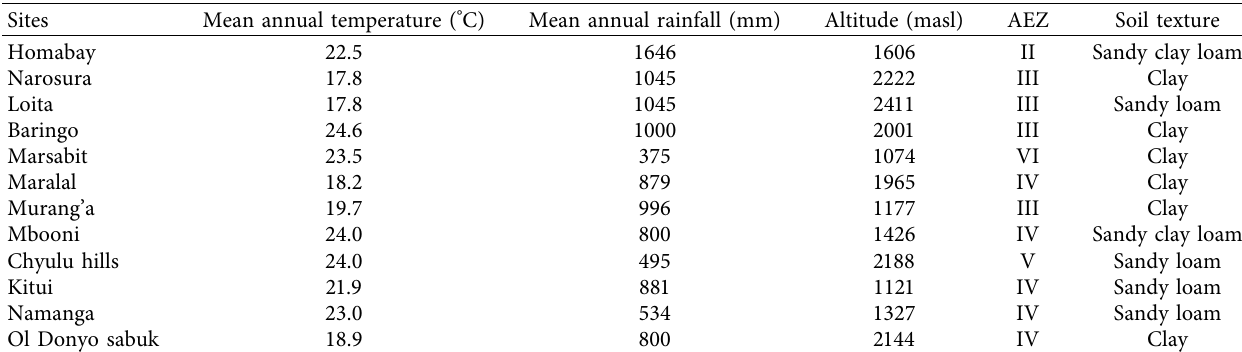
Figure 1: Map of Kenya showing study Table 1: Agroclimatic and soil characteristics of the study site.